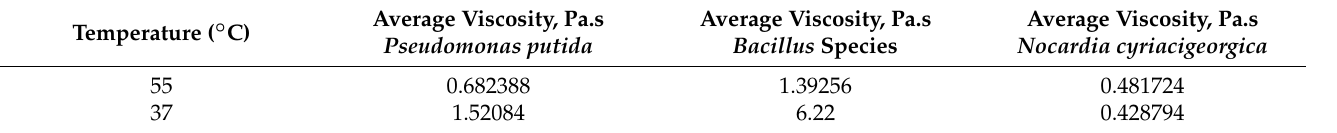
Table 4. Comparing average viscosity of crude oil after using bacterial species at different temperature conditions.